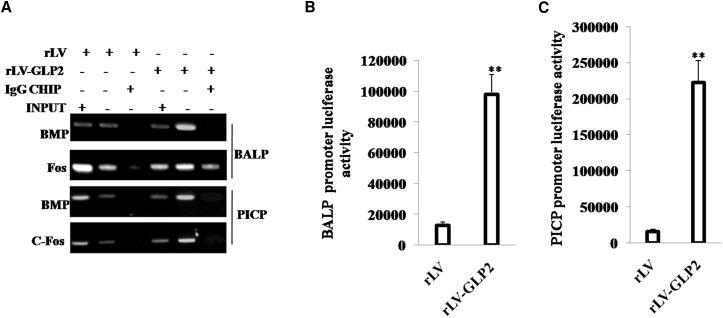
GLP2 Enhances the Expression of BALP, PICP via c-Fos and BMP(A) ChIP assay with anti-BMP, anti-FOS followed by PCR with DNA primers of BALP and PICP in OB cells induced from MG63 infected with rLV-GLP2 or rLV, respectively. IgG ChIP was the negative control. (B) The assay of luciferase activity of promoter of BALP in OB cells induced from MG63 infected with rLV-GLP2 or rLV, respectively. **p < 0.01. (C) The assay of luciferase activity of promoter of PICP in OB cells induced from MG63 infected with rLV-GLP2 or rLV, respectively. **p < 0.01.